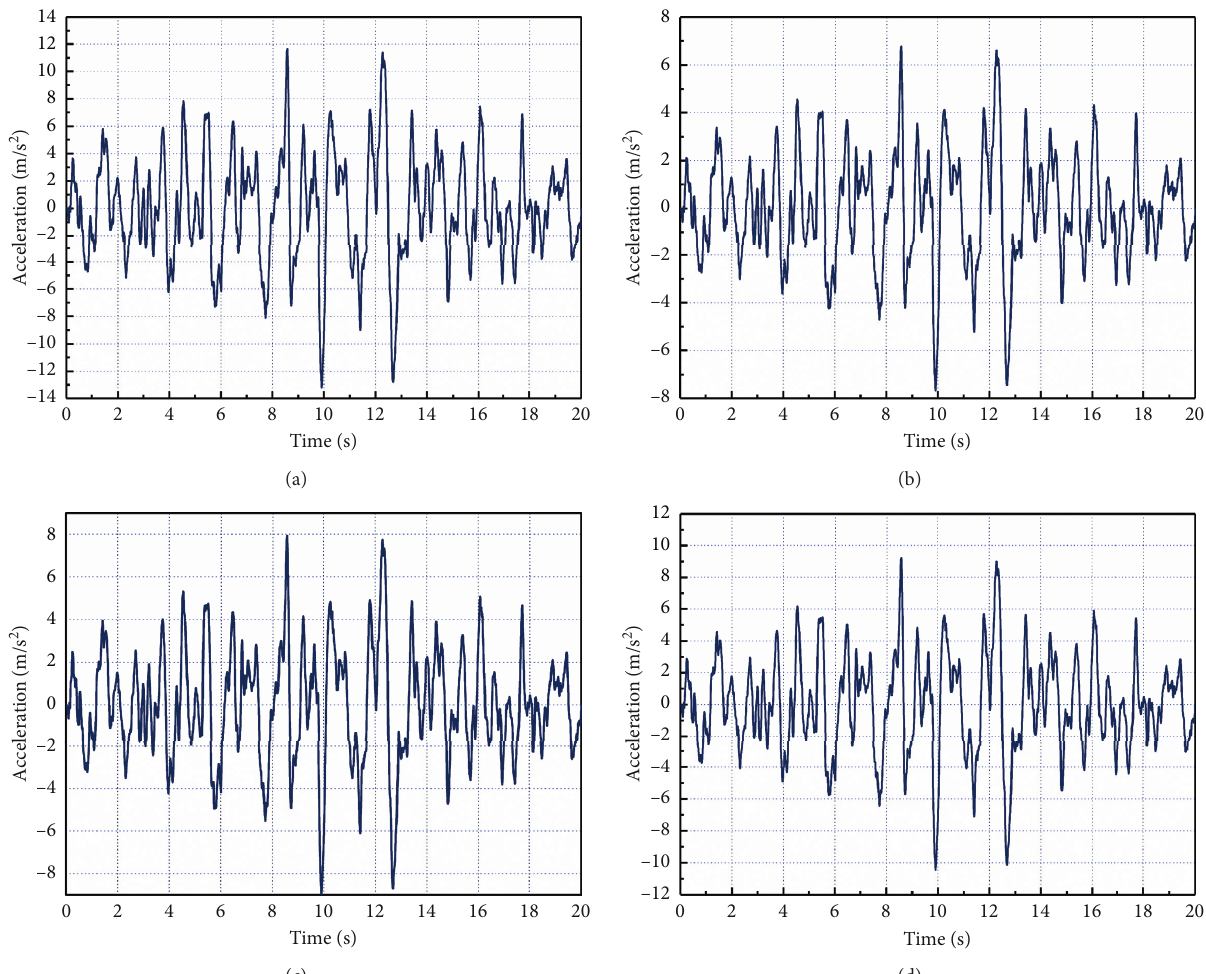
Figure 8: Acceleration responses. (a) Fault zone. (b) Rock mass. (c) Fault zone with hock absorption layer. (d) Fault zone with seismic joints.